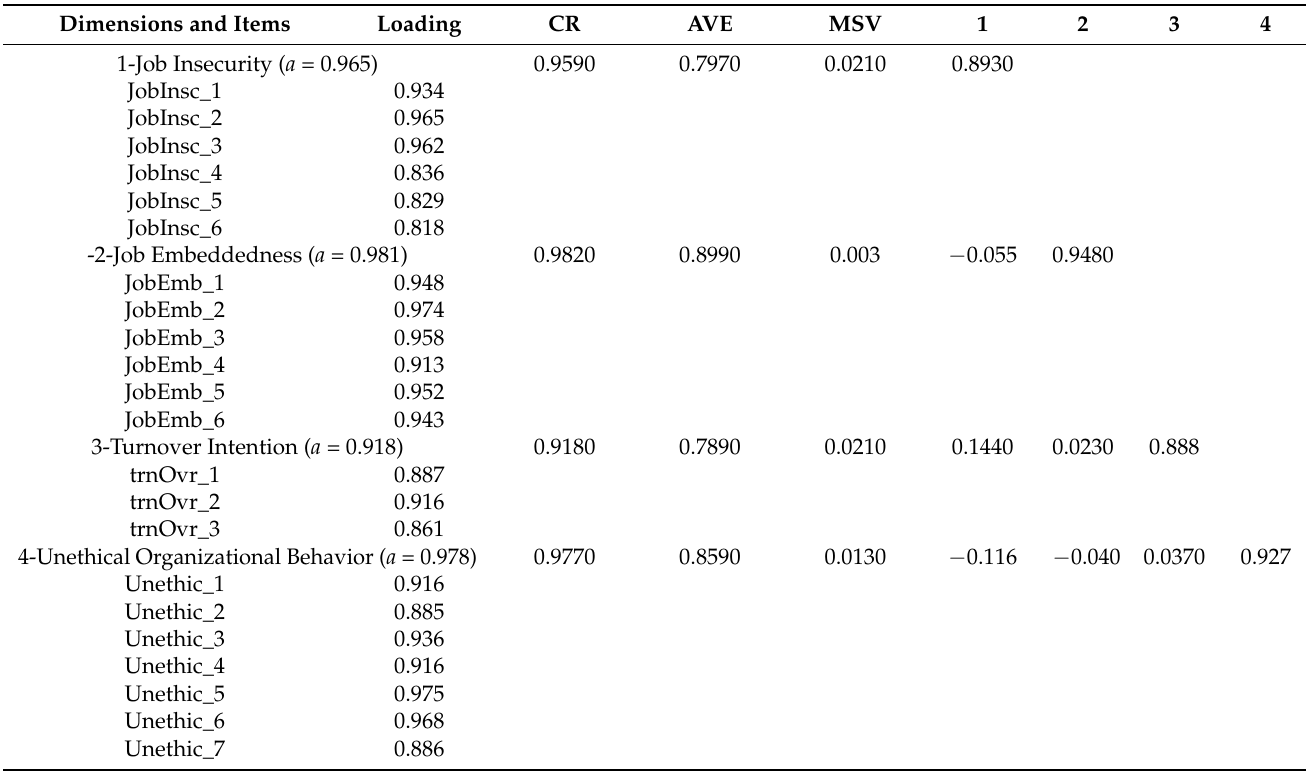
Table 3. Convergent and discriminant validity (developed by